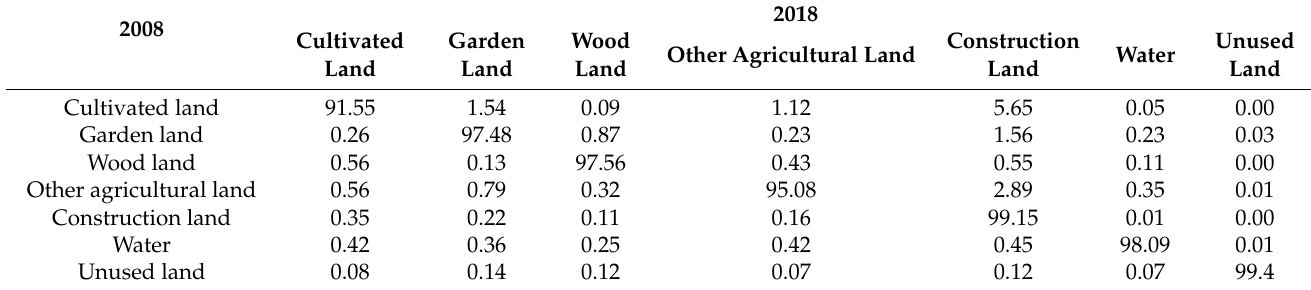
Table 2. Transformation matrix of landscape types in Suzhou City from 2008 to 2018